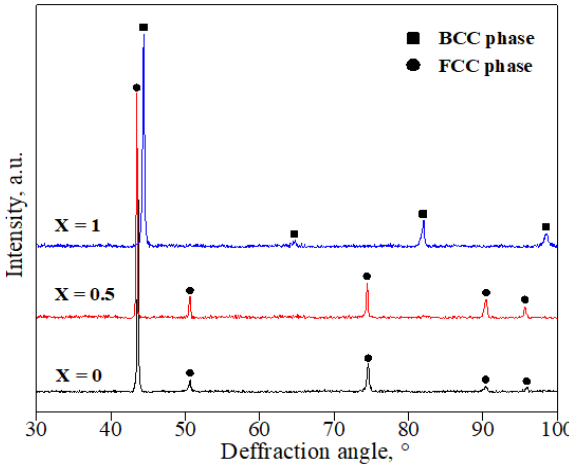
Figure 4. XRD patterns of the coatings with different Al contents.